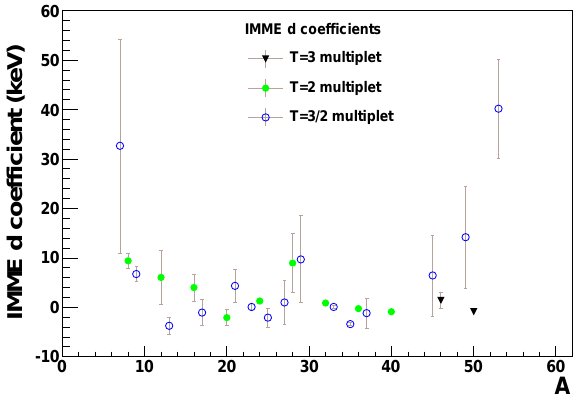
Figure 4. d coe ffi cients, in keV, shown as a function of atomic mass number A extracted from a third degree IMME polynomial fit: a + bT z + cT 2